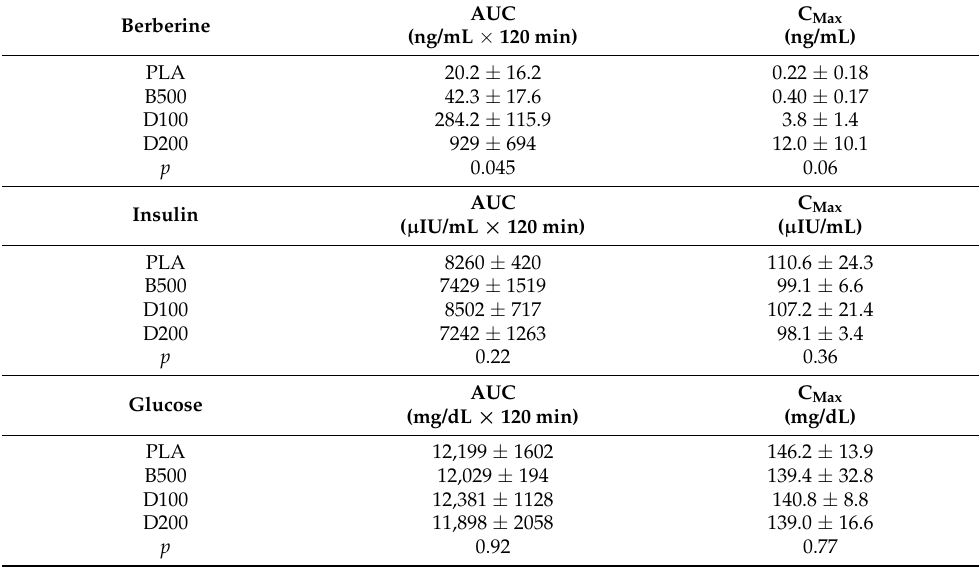
Table 5. Area under the curve (AUC) and concentration max (C Max ) for berberine, insulin, and